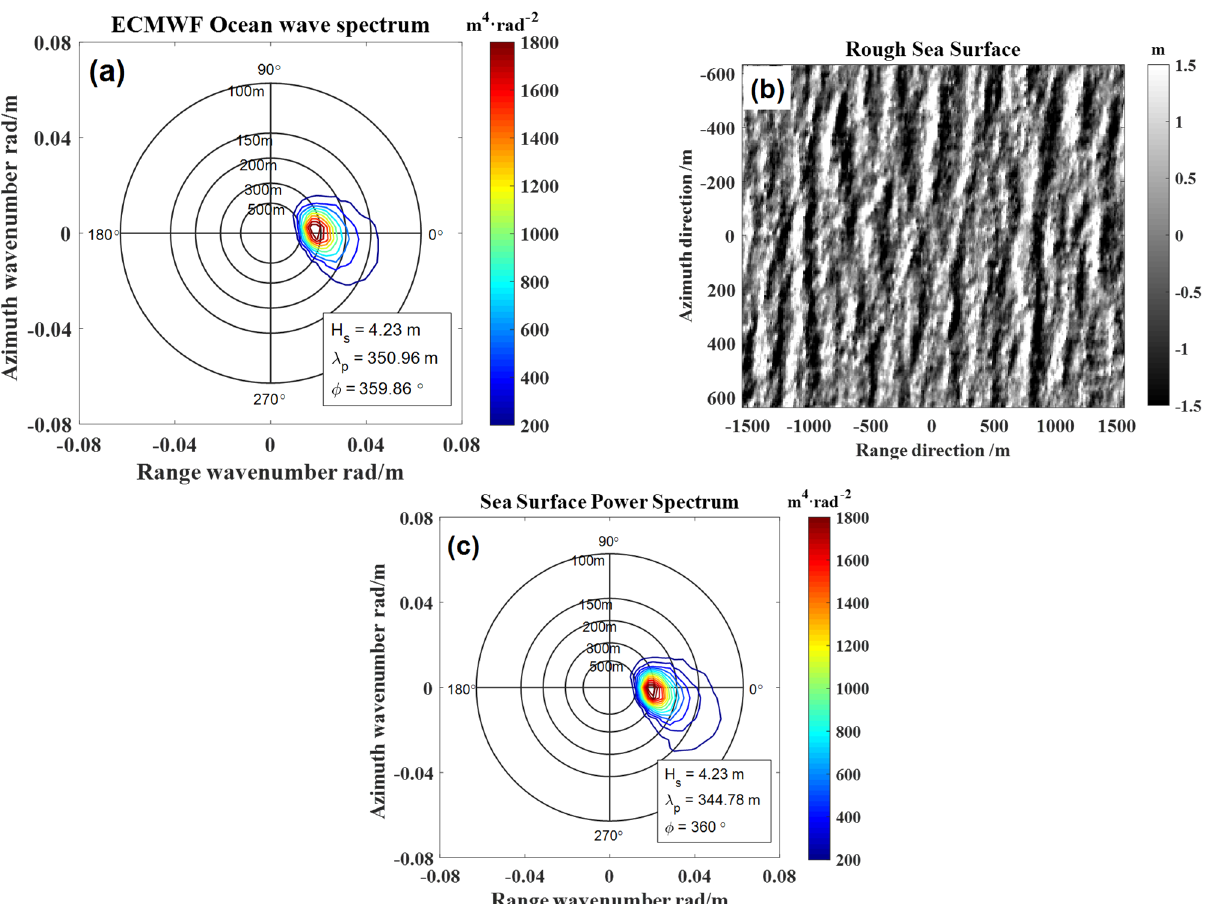
Figure 2. The reanalysis ocean wave spectrum corresponding to SAR ID 1 ( a ), the reconstructed sea surface ( b ), and the spectrum of the reconstructed sea surface ( c ).